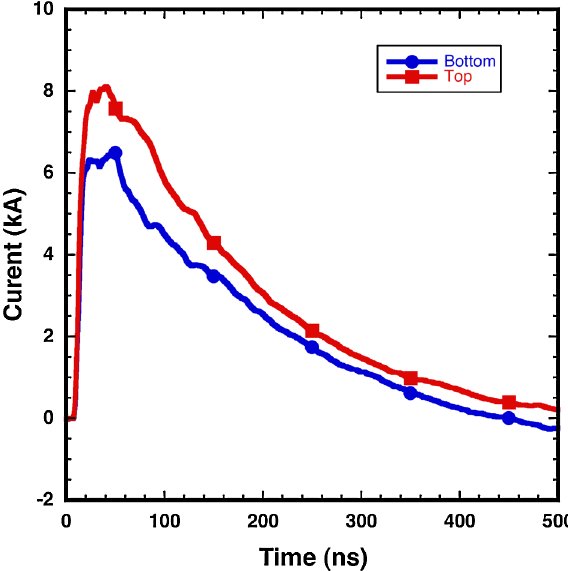
FIG. 8. (Color) Currents measured on each half of the switch system. of time. If the current were shared perfectly, the scale factor would be unity. With current measured on both halves of the switch, and neglecting transit time between the switch halves (3.2 ns), the ratio of the two resistors can be found to be